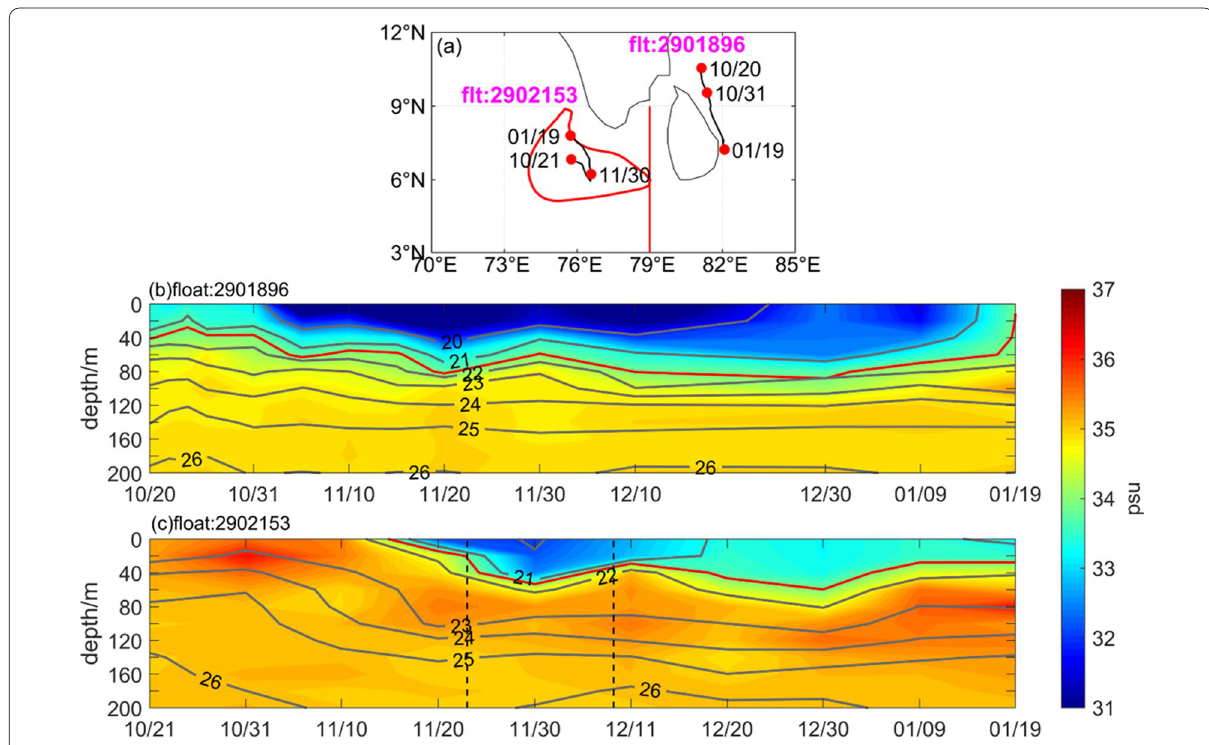
Fig.5 Trajectory maps ( a ) and salinity profile ( b , c ) from the two Argo floats from 20 October 2016 to 19 January 2017 as well as the anticyclonic eddy edge ( a ) on 30 November. The red line in a is the transect (79°E, 0–8°N). The gray contour lines represent the potential density and the red contour line represents the salinity of 33.9. Dashed lines represent the period when the Argo float is inside the